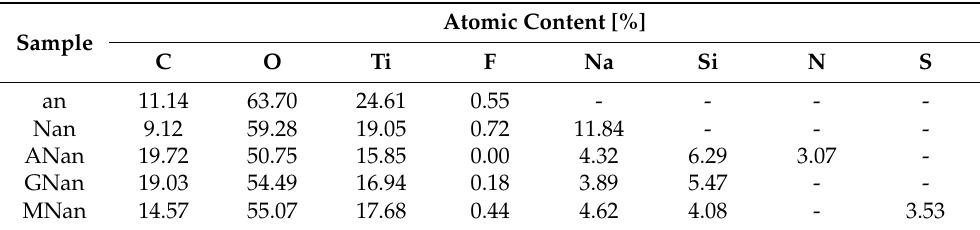
Figure 3. XPS (X-Ray Photoelectron Spectroscopy) survey spectra of the non-modified (an) and modified (Nan, Anan, GNan, and MNan) TiO 2 samples. Table 1. Elemental compositions of non-modified (an) and modified (Nan, Anan, GNan, and MNan) TiO 2 samples based on the XPS